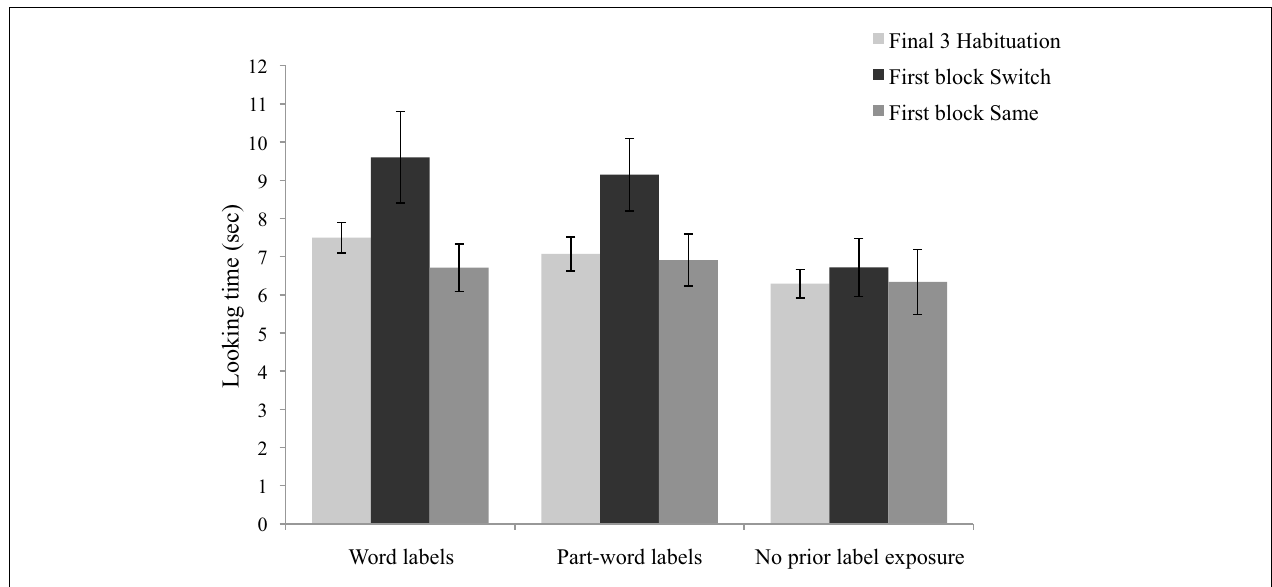
FIGURE 4 | Mean looking time (in seconds) to word and part-word labels (Experiment 2A), and labels with no prior segmentation phase exposure (Experiment 2B) during the final three habituation trials and the first block of switch and same test trials. Error bars represent standard errors.